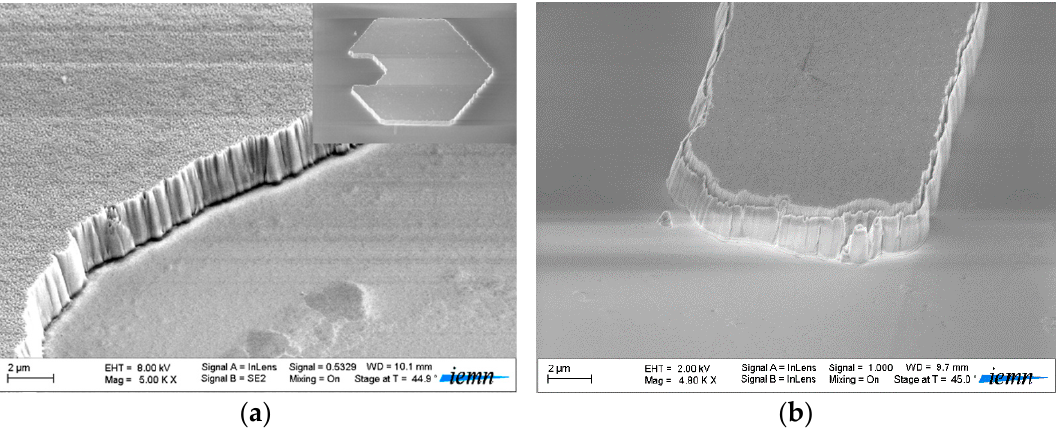
Figure 4. SEM images of mesa sidewalls using a photoresist mask: total etching depth of 1.5 µm, with a mesa width of ( a ) 100 µm and ( b ) 10 µm -ICP power of 150 Watts.